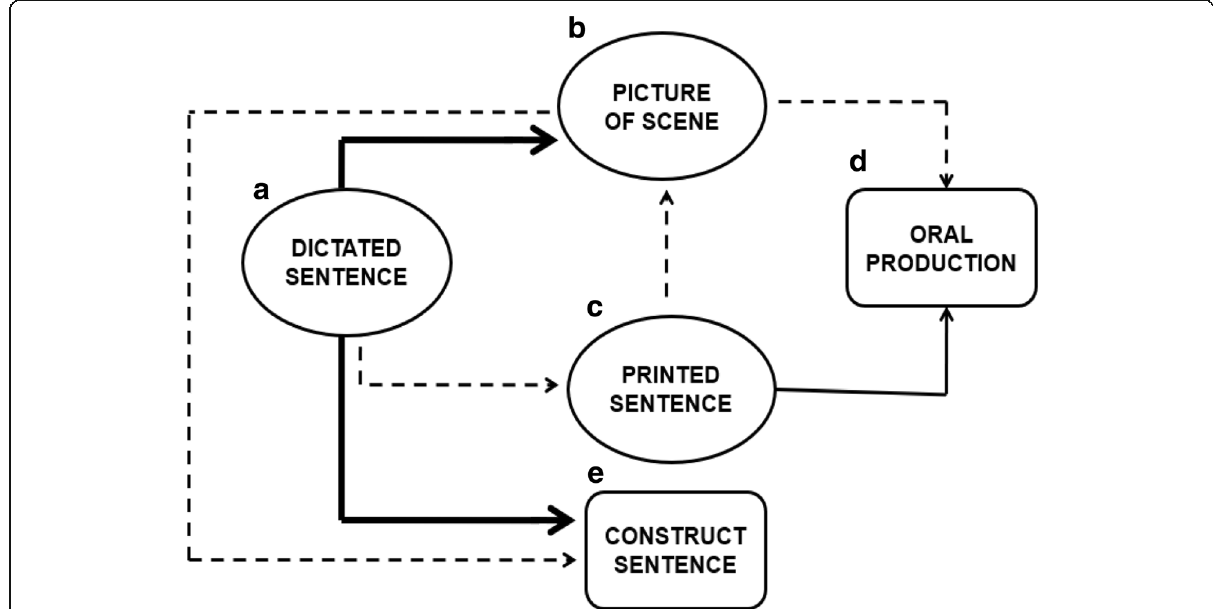
Fig. 2 Equivalence relations network in present study. Adopted from Mackay (2013). Circles A, B, and C represent stimuli. Box D represents oral production by the participant. Box E represents word-by-word construction of the sentences. Arrows indicate relations and point from sample to comparison stimuli of matching-to-sample or constructed-response matching-to-sample tasks (AB, AC, CB, AE, and BE); arrows that indicate verbal operants point from antecedent stimuli to response (CD and BD). Solid arrows show relations already learned (CD). Heavy solid arrow shows trained relations (AB and AE). Broken arrows identify untrained